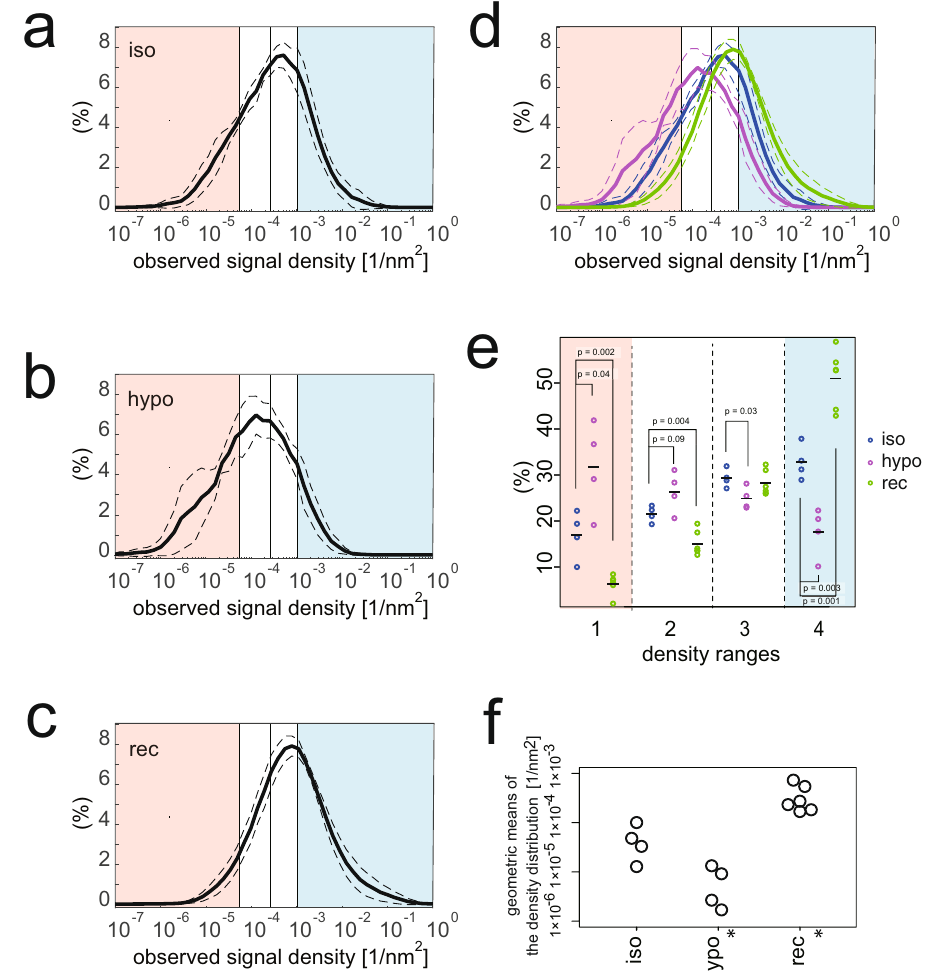
Figure 7. Local density estimation from PALM signals of caveolin-1-Dendra2. ( a – d ) The average density distributions of the PALM signals by the 4 th NND of caveolin-1-Dendra2-expressing cells under ( a ) isotonic medium (iso), ( b ) hypotonic treatments of 5 min (hypo), and ( c ) hypotonic treatments of 5 min followed by isotonic medium for 5 min recovery (rec), as analysed in Fig. 3. The dashed line indicates the standard deviation. The dotted line indicates the peak in ( a ). In ( d ), the superposition of ( a – c ) is shown. ( e ) Percentages of caveolin-1 by the density ranges in each cell as in Fig. 3f. The average percentages at the dispersed caveolin-1 range between cells under isotonic medium and cells treated with hypotonic medium or recovered cells were significantly different. Indicated p-values were obtained using the Student’s t-test. ( f ) The geometric means of the density distribution in each cell in ( a–c ). The average geometric means between cells in isotonic medium and the treated cells were significantly different ( * ) with p = 0.02 (hypo) and 0.002 (rec) obtained using the Student’s